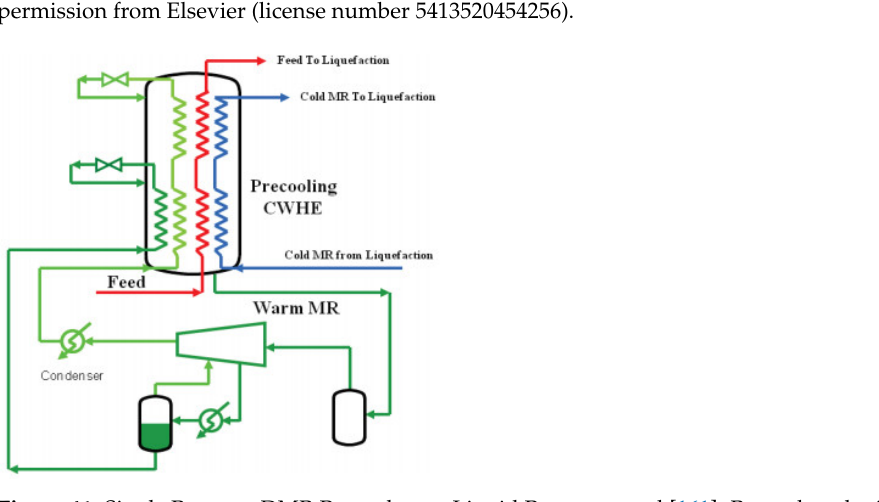
Figure 41. Single Pressure DMR Precooler, no Liquid Pump-around [161]. Reproduced with permis- sion from Elsevier (license number